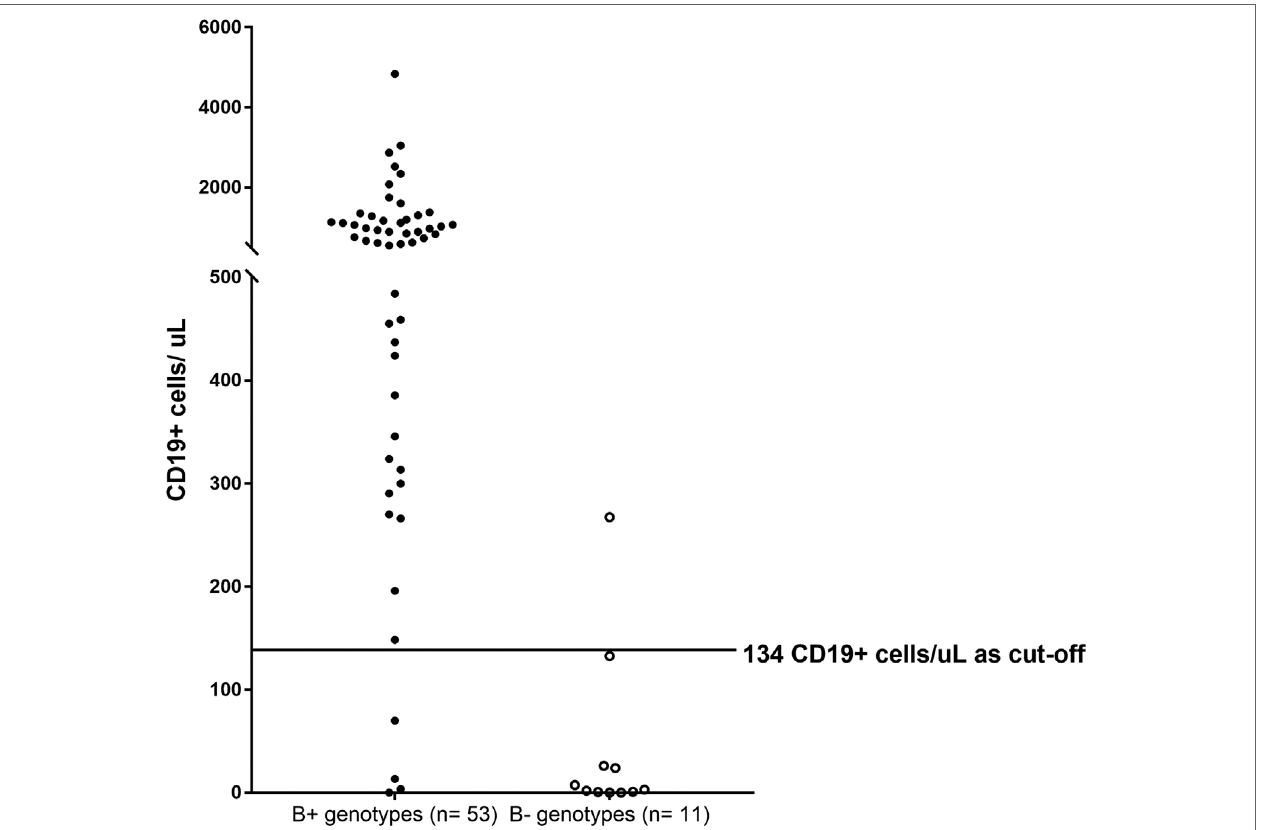
FigUre 1 | CD19 + cell counts of patients with B + and B − genotypes. B + genotypes group consisted of CD19 + cell counts of patients with mutations found in IL2RG ( n = 43), IL7R ( n = 3), and JAK3 ( n = 5). B − genotypes group consisted of CD19 + cell counts of patients with mutations found in ADA ( n = 1), DCLRE1C ( n = 3), RAG1 ( n = 3), and RAG2 ( n = 2). The cutoff for distinguishing B + and B − patients was 134 CD19 + cells/ μ L. Three patients with IL2RG mutations were classified as having B −